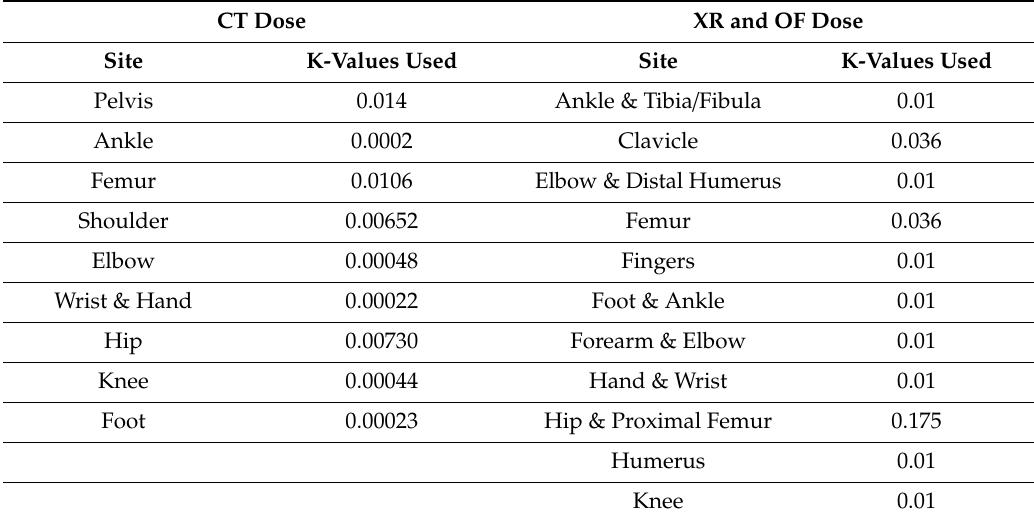
Table 1. K-values used for dose calculation (CT) mSv = K × mGy.cm 2 and (XR and OF) mSv = K × Gy.cm 2 . CT Dose XR and OF